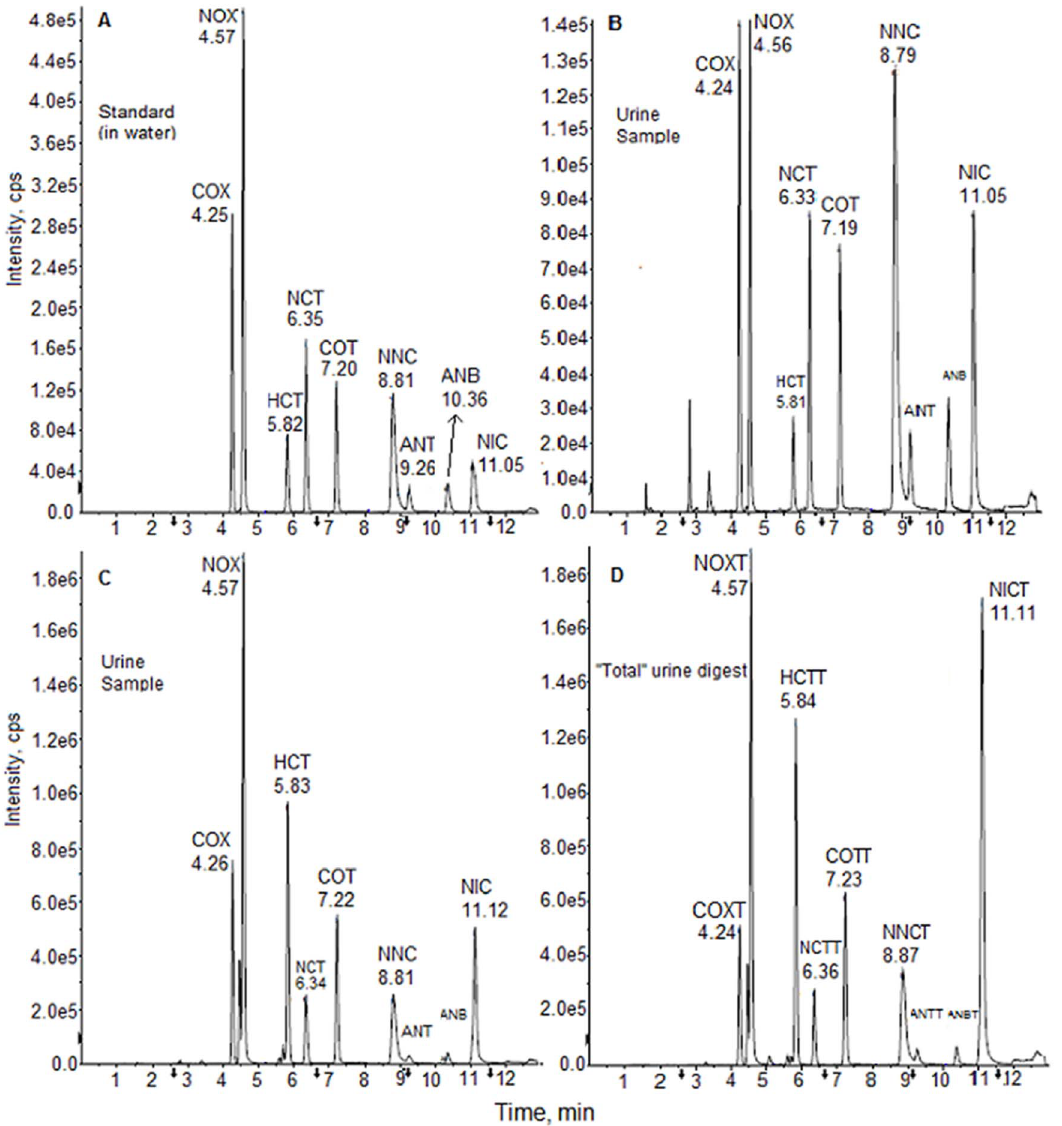
Figure 2. Representative chromatograms. (A) Standards Analysis (cotinine, 200 ng/mL); (B) Smoker Urine Sample (‘‘free’’ cotinine, 14.1 ng/mL); (C) Smoker Urine Sample (‘‘free’’ cotinine, 2767 ng/mL); (D) Smoker Urine Sample (‘‘total’’ cotinine, 4195 ng/mL). Abbreviations: Cotinine-oxide (COX); Nicotine-oxide NOX); Hydroxycotine (HCT); Norcotinine (NCT); Cotinine (COT); Nornicotine (NNC); Anatabine (ANT); Anabasine (ANB); Nicotine (NIC). The fourth letter ‘‘T’’ in the abbreviations in Figure 2(D) represents the ‘‘total’’ concentrations for measured